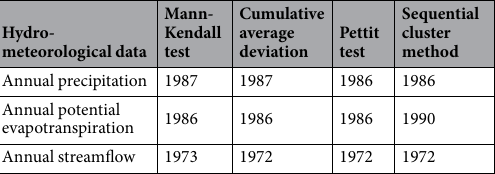
Table 2. The change point of meteorological and hydrological factors in the Tarim River Basin during 1960~2015.